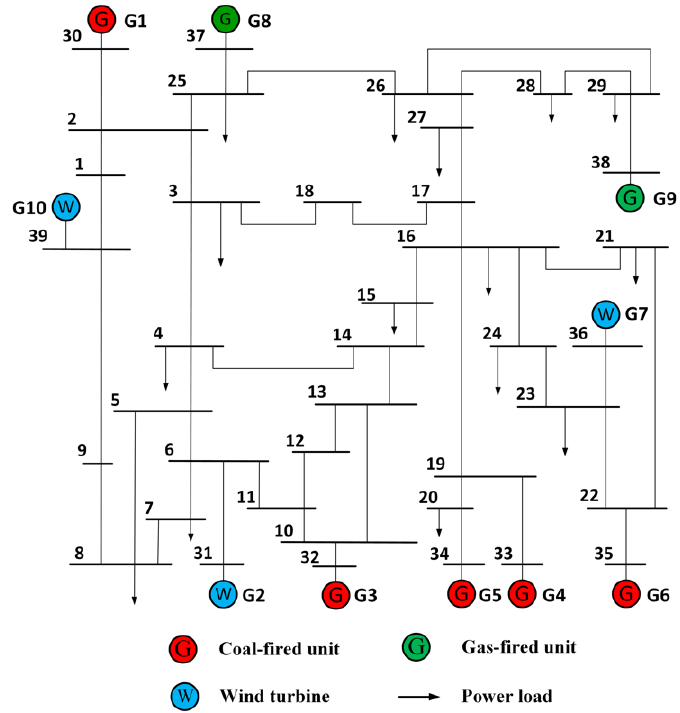
Figure 4. Modified IEEE 39-bus power system.